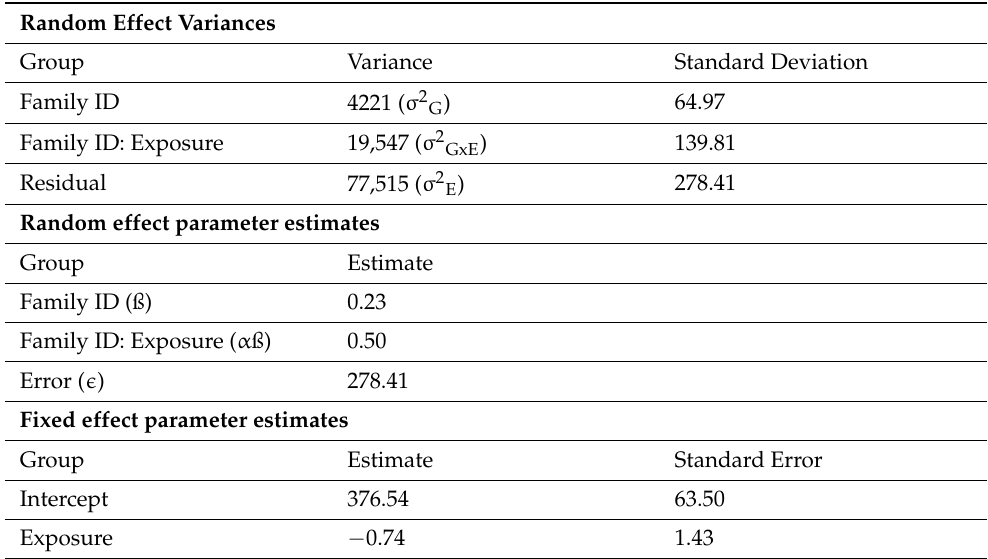
Table 3. Results from fitting LMM to behavioral